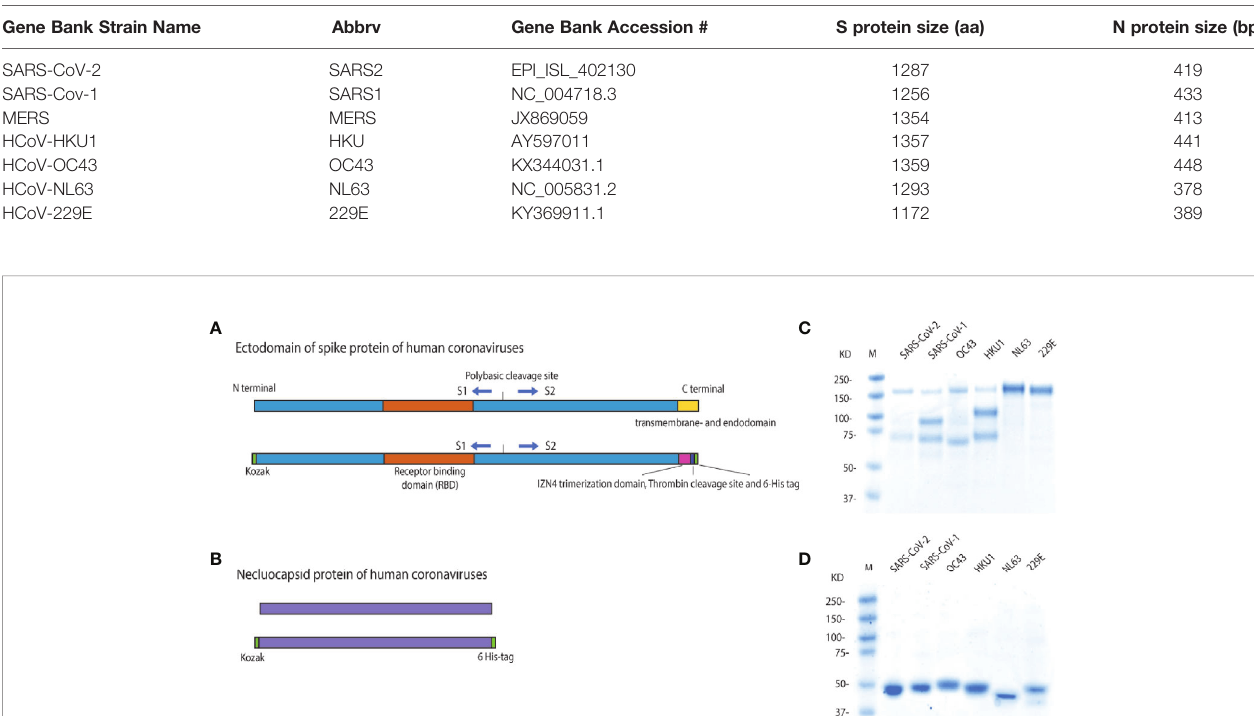
Table S2 ). Secondary antibodies were PE-conjugated anti-